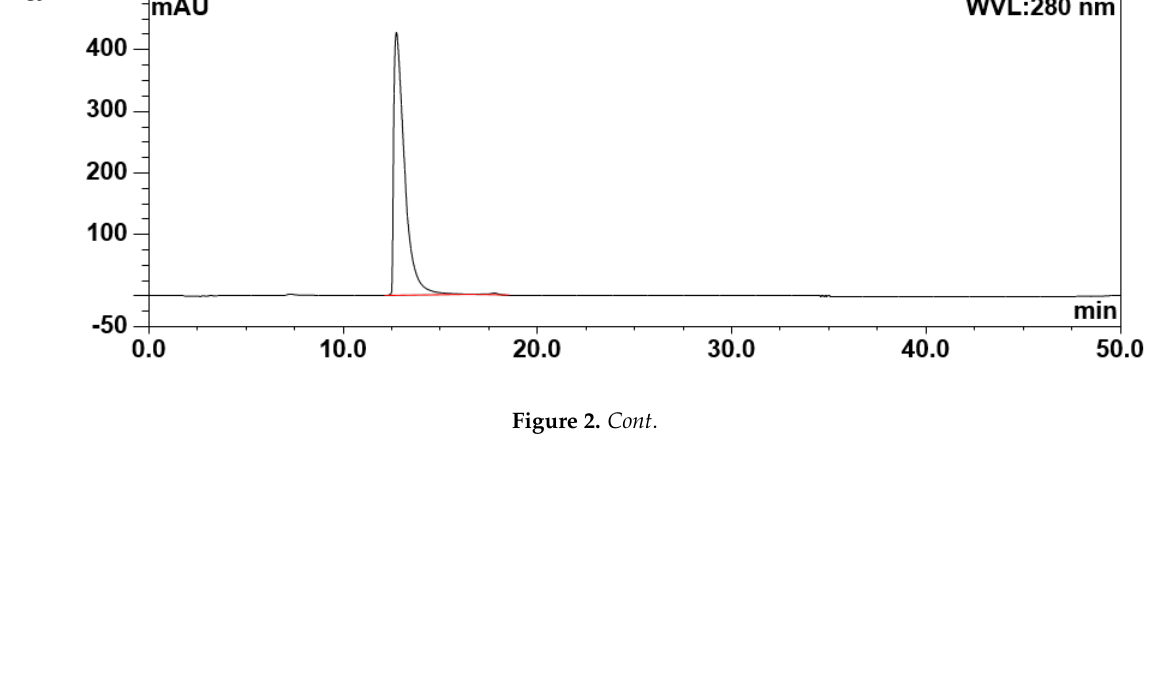
Figure 2. HPLC chromatograms of Avn-C isolated from Fr. 2. Avn-C was detected by UV 254 nm (a), UV 365 nm (b), and ELSD (c). Compound 1 : light green powder; 1 H-NMR (500 MHz, MeOH- d 4 ): δ8.45 (1H, d, J = 9.0 Hz, H-3), 7.52 (1H, d, J = 3.2 Hz, H-6), 7.50 (1H, d, J = 15.6 Hz, H-7 ’ ), 7.07 (1H, d, J = 1.7 Hz, H-2 ’ ), 7.02 (1H, dd, J = 9.0 and 3.2 Hz, H-4), 6.97 (1H, dd, J = 8.2 and 1.7 Hz, H-6 ’ ), 6.79 (1H, d, J = 8.2 Hz, H-5 ’ ), and 6.46 (1H, d, J = 15.6 Hz, H-8 ’ ) (Figure 3). From these data, compound 1 was postulated as Avn-C and this was finally confirmed by a comparison of these results from the 1 H-NMR analysis with those of a previous study [32].